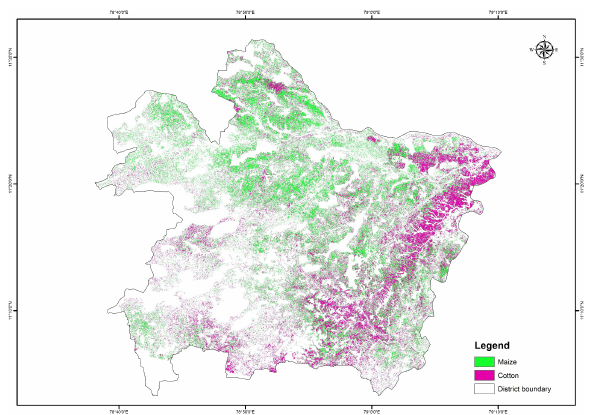
Figure 5. Classified image using unsupervised classification for